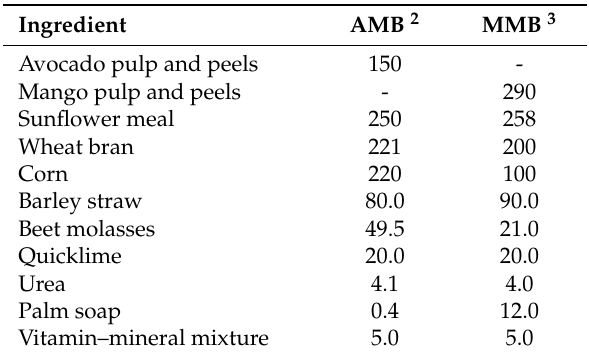
Table 1. Ingredient composition (g / kg fresh matter) of multi-nutrient blocks including a mixture of pulp and peels either from avocado tested in Experiment 2 1 . Ingredient AMB 2 MMB 3 Avocado pulp and peels 150 - Mango pulp and peels - 290 Sunflower